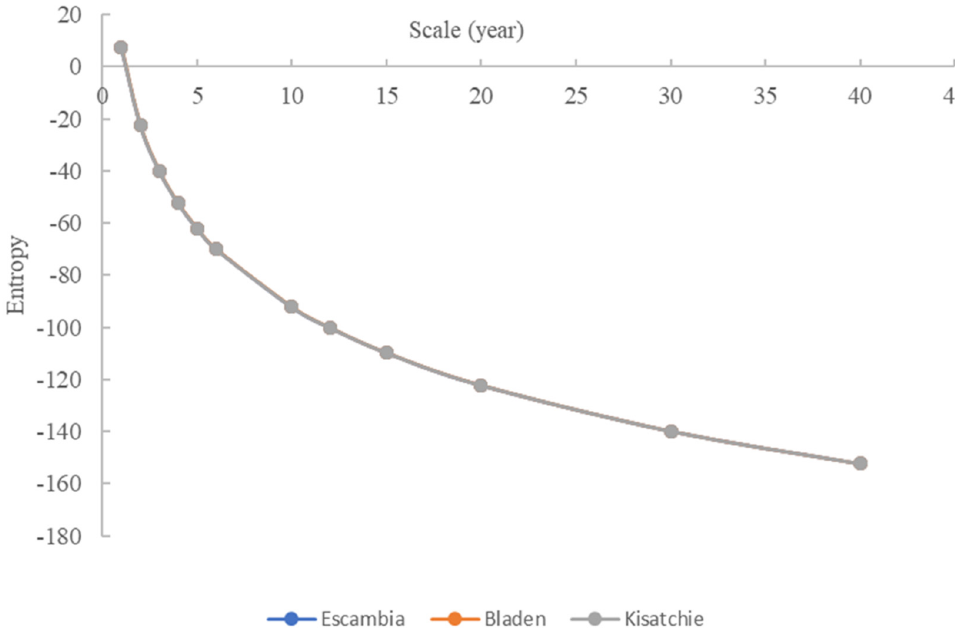
Figure 7. The entropy dynamics of annual precipitation at multi-year at the three sites. Table 3. The maximum and minimum values of SPEI at three